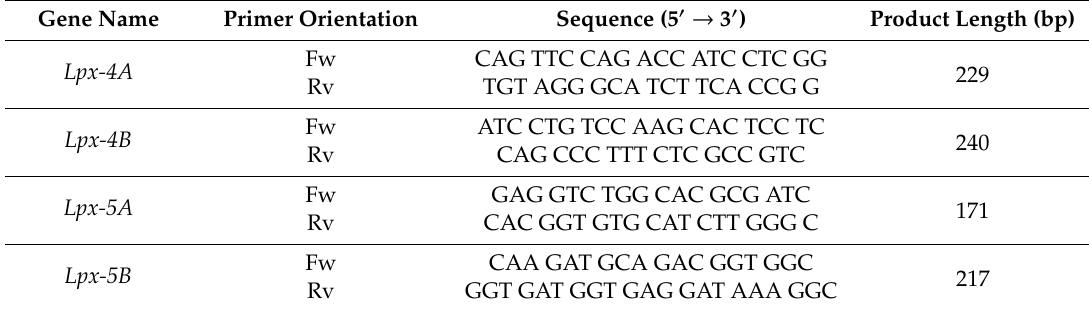
Table 9. Primer pairs used for Lpx gene expression analysis in the RIL